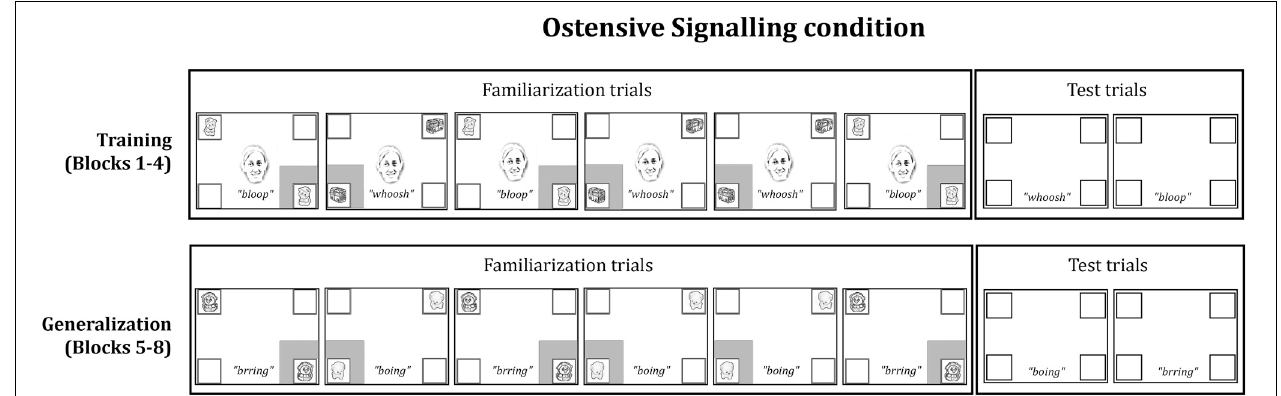
FIGURE 1 | Schematic of one block of familiarization and test trials from the Ostensive Signaling condition (Training and Generalization phases). The presentation of familiarization events was pseudo-randomized among